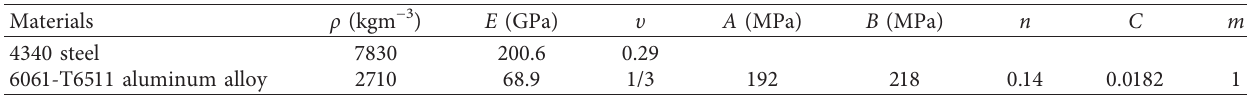
Figure 9: Meshing results of the finite element model: (a) global meshing and (b) projectile meshing. Table 3: Parameters of material models.